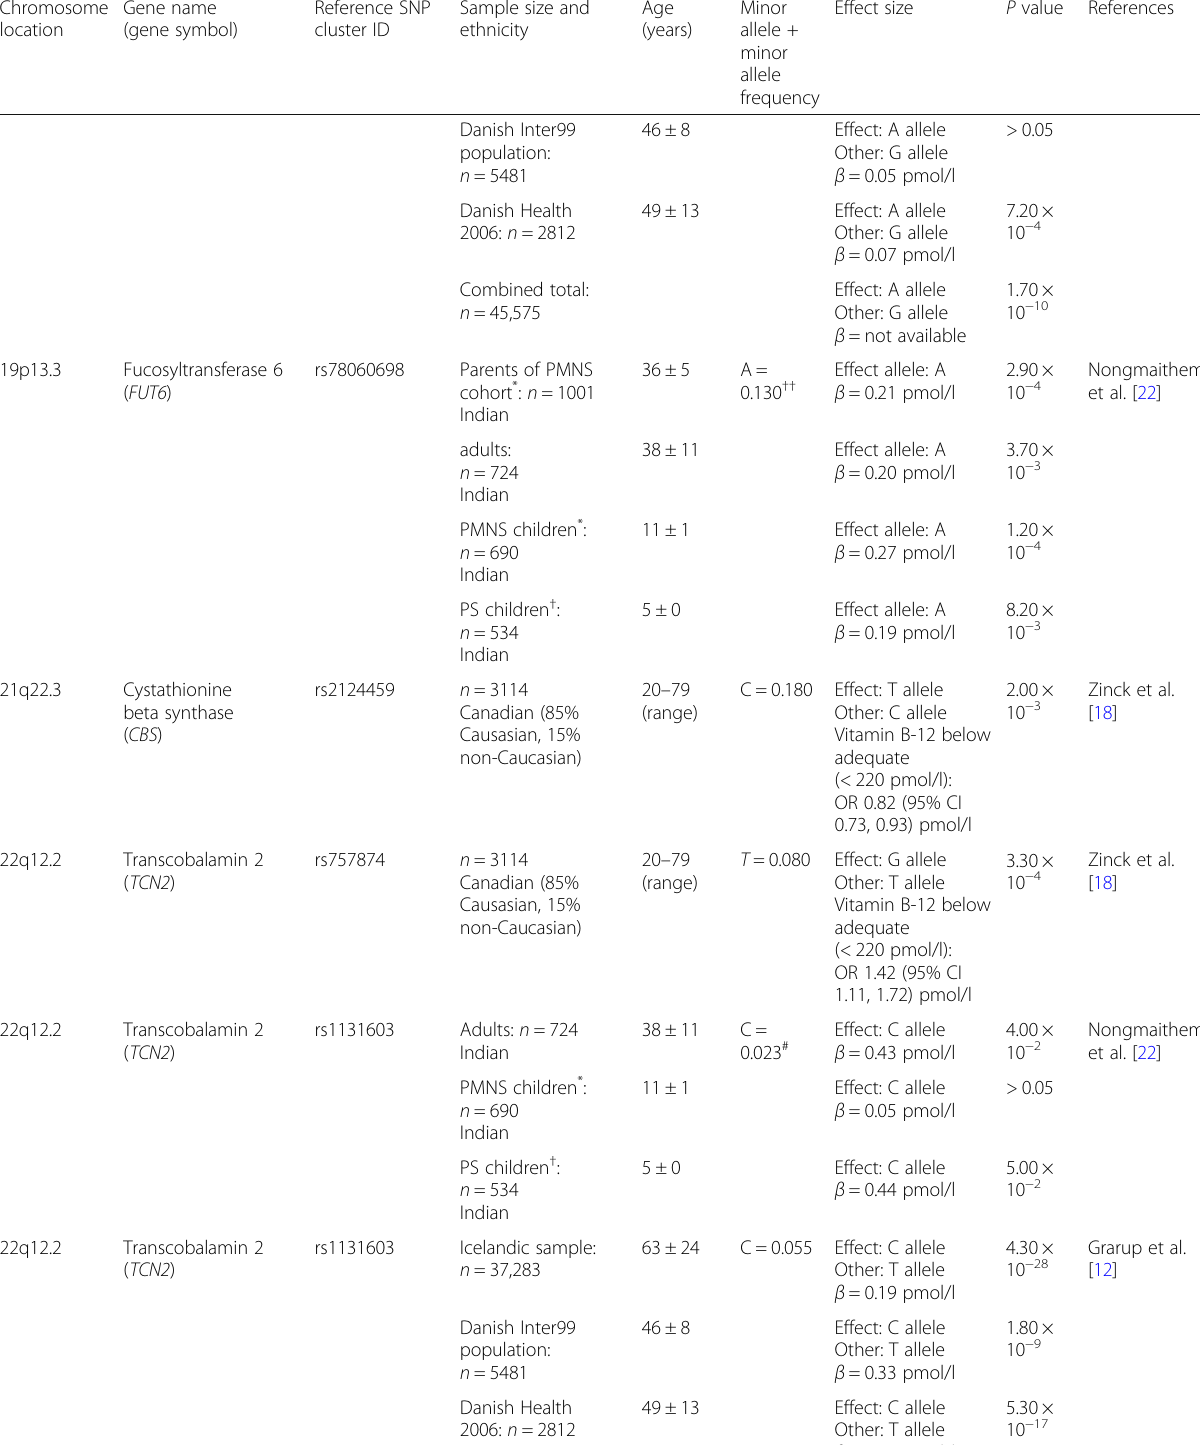
Table 1 Genome-wide association studies showing the association of SNPs with vitamin B12 concentrations. Genome-wide association studies testing the association between SNPs and vitamin B12 concentrations. The chromosome location, gene name, reference SNP cluster ID, sample size and ethnicity, mean age, observed frequency of the minor allele in the population, effect size and P value are shown in the table. The order of SNPs reflects the order of the chromosome location